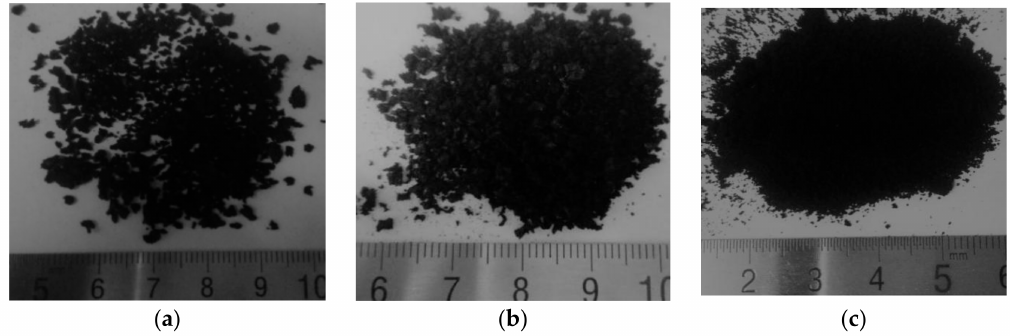
Figure 2. A photographic view of rubber particles ( a ) 3~5 mm, ( b ) 1~3 mm, and ( c ) 40 mesh.